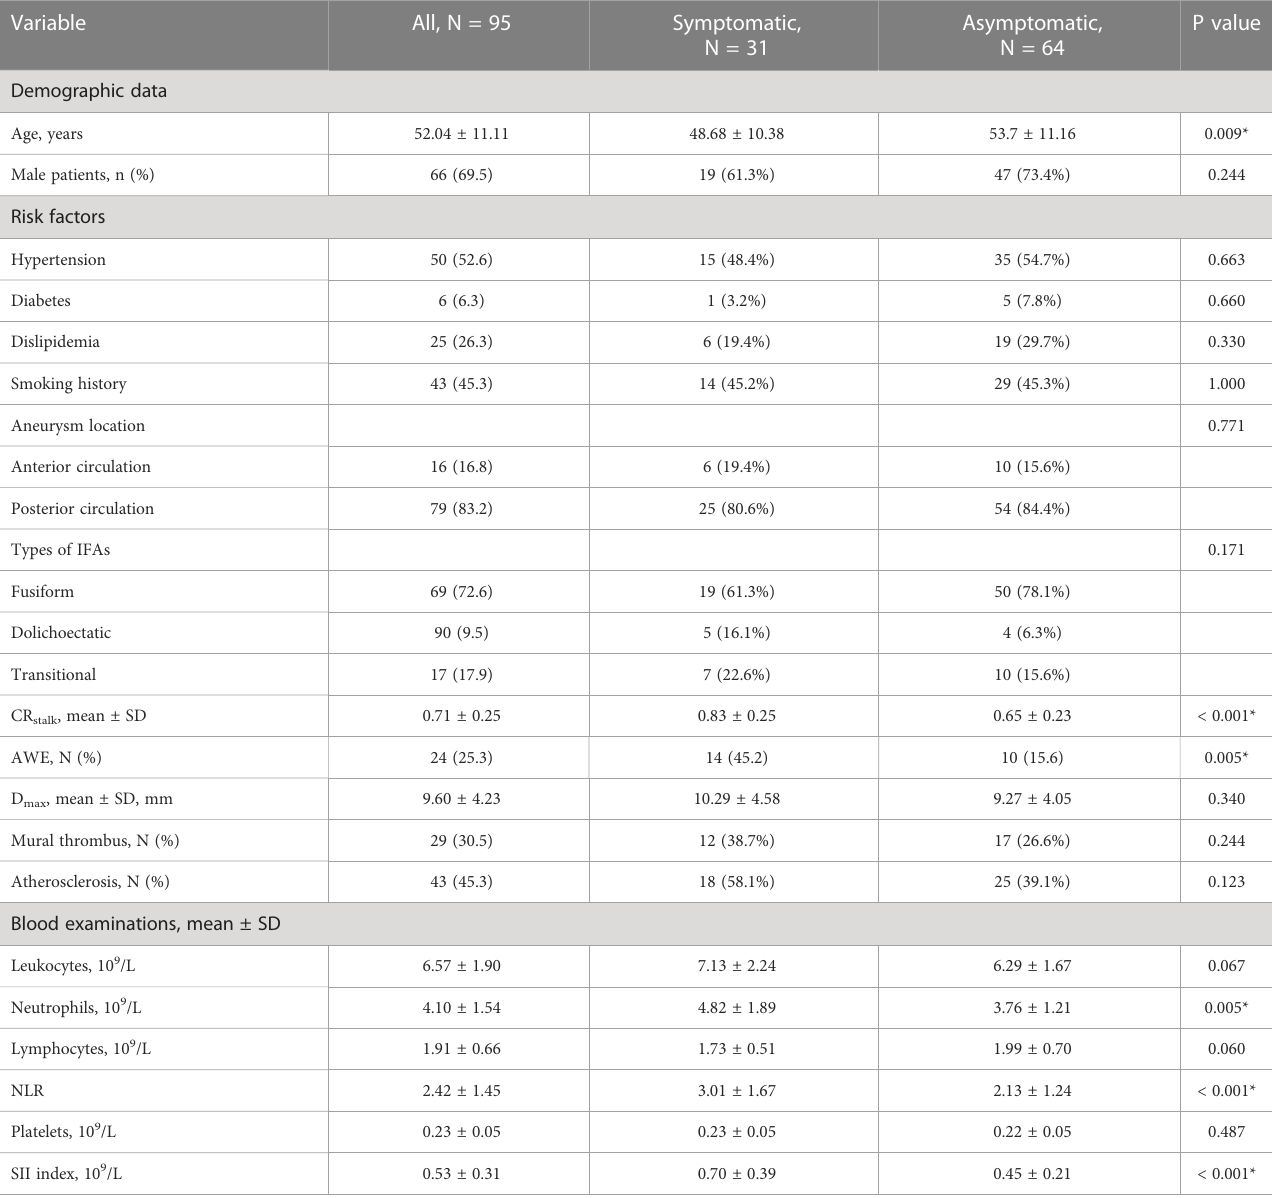
TABLE 3 Baseline characteristics of IFA patients with and without aneurysmal symptoms.